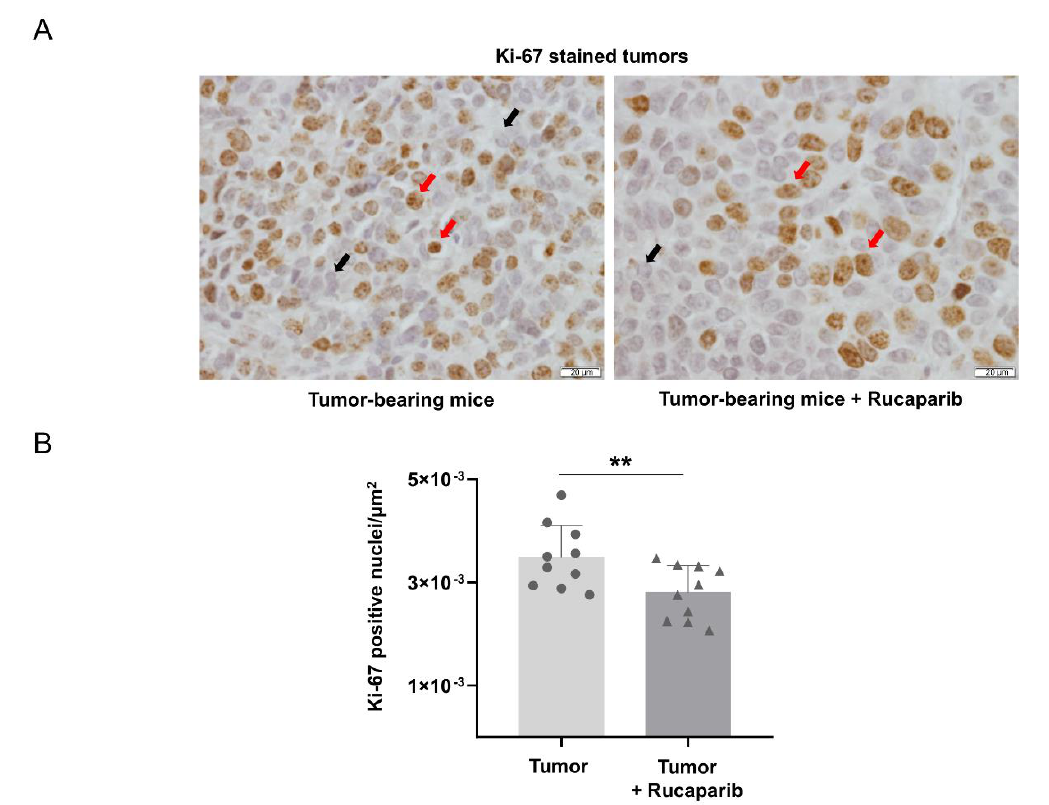
Figure 5. Representative examples of nuclei positively stained for Ki-67 (red arrows point towards brown nuclei) and not stained (black arrows point towards blue nuclei, hematoxylin counterstaining) in tumors of both experimental groups ( A ). Mean values and standard deviations of positively stained nuclei for Ki-67 in the total measured area ( B ). In the scatter plot, the circles represent the untreated tumor-bearing mice while the triangles represent the rucaparib treated tumor-bearing mice. Statistical significance: ** p ≤ 0.01 between tumor-bearing mice treated with rucaparib and non-treated tumor-bearing mice. Scale bar = 20 μm, 40 × magnification.